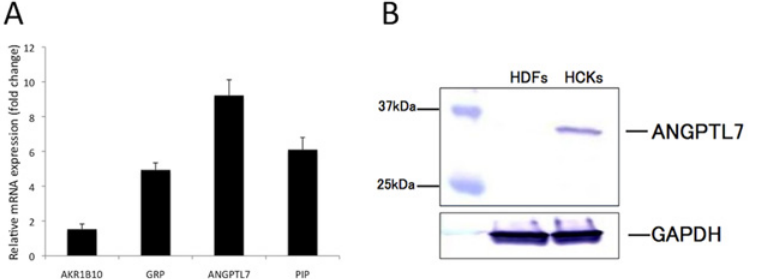
Figure 3. Relative expression of ANGPTL7 in HCKs and HDFs. AKR1B10, GRP, ANGPTL7 , and PIP levels were elevated in the cDNA derived from HCKs as compared to with that from HDFs (A). In western blot analysis, ANGPTL7 was detected in culture media collected from HCKs but not i HDFs (B). N = 3 per condition.